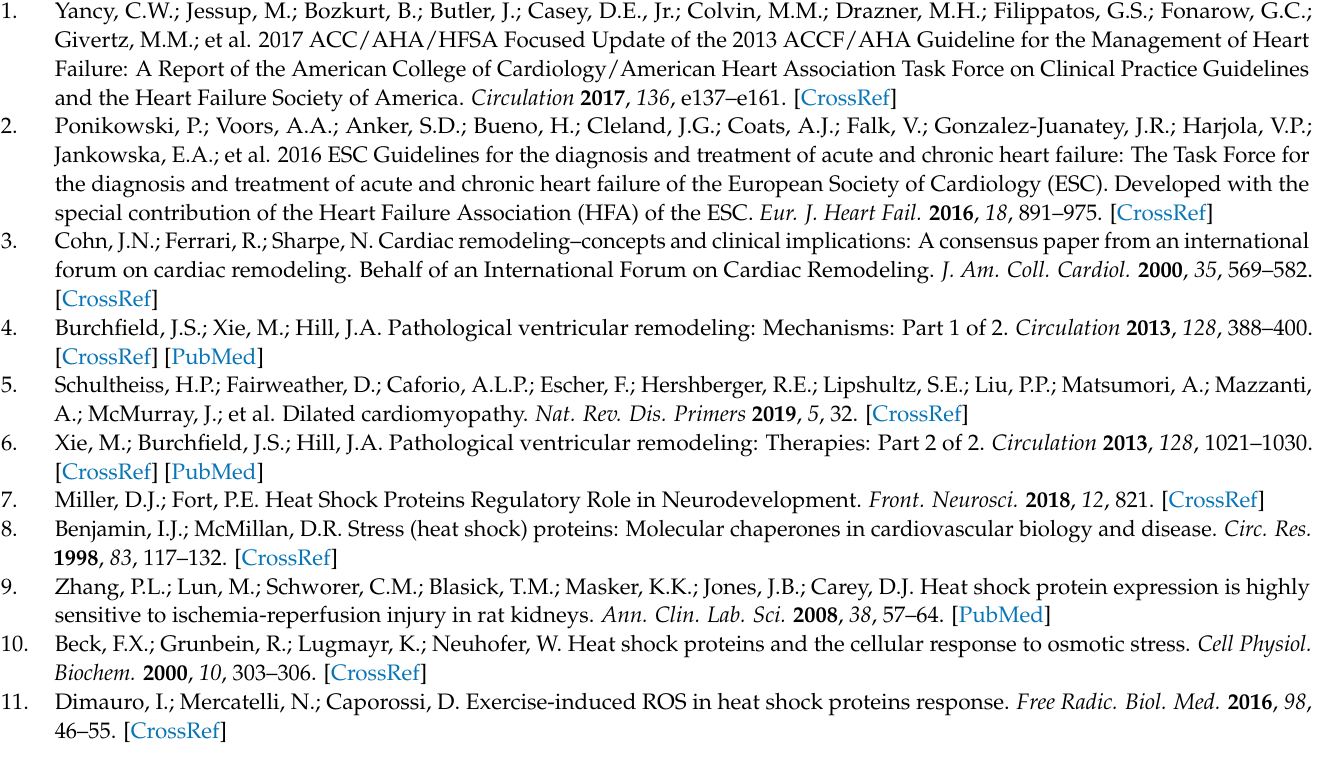
Figure S2: Phosphorylation profiles in hearts from younger